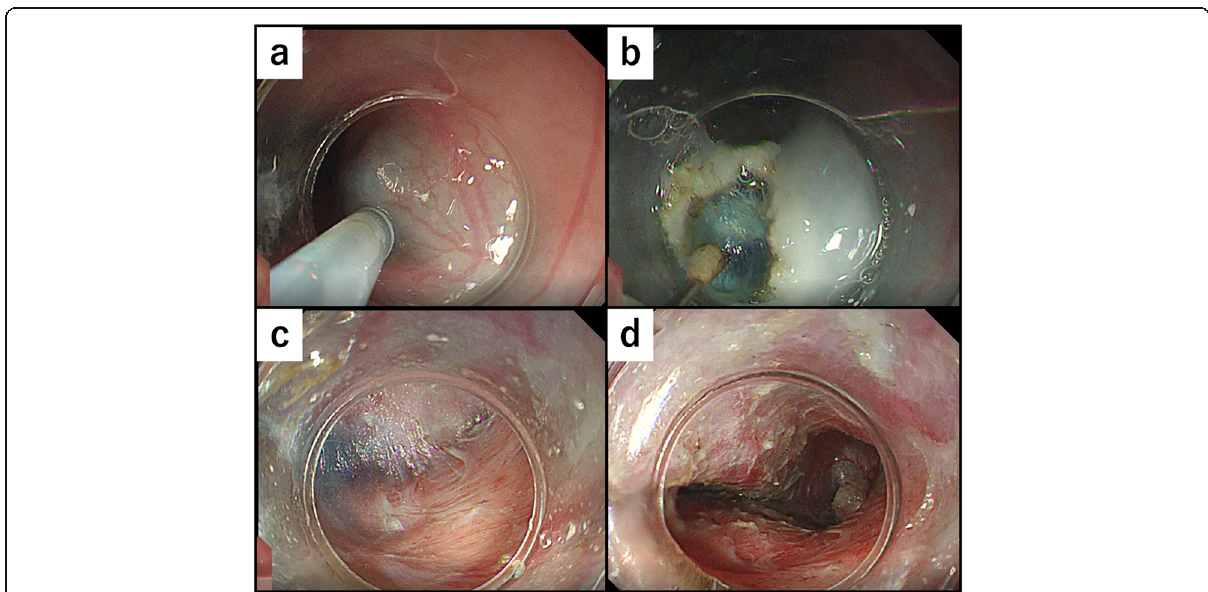
Fig. 4 Endoscopic surgical procedure. a Injecting indigo carmine into the submucosal layer. b Creating the entry to the submucosal tunnel 30-mm proximal to the oral edge of the tumor. c Dissecting the layer between the mucosal and muscular layers. d Extending the submucosal tunnel beyond the anal edge of the tumor and separating the tumor from the mucosa